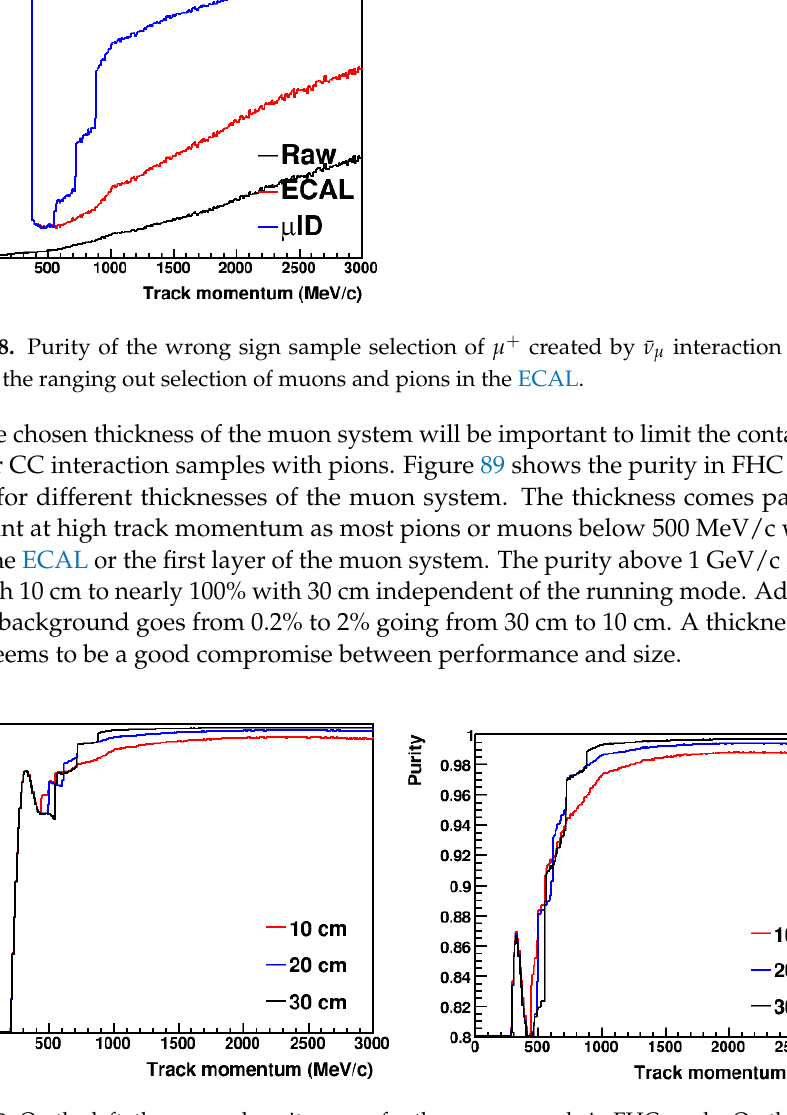
Figure 89. On the left, the zoomed purity curve for the muon sample in FHC mode. On the right, the zoomed purity curve for the muon sample in RHC mode. Both plots shows the purity for different thicknesses of the muon system between 10 and 30